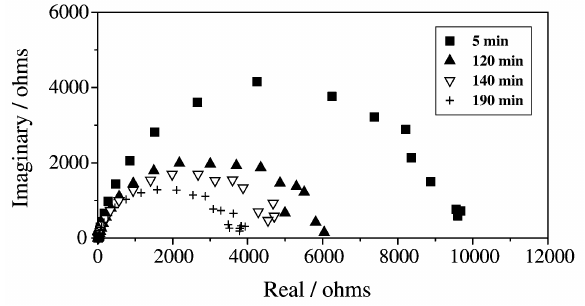
Figure 1. AFM topography images of the coatings before the electro- chemical experiments: (a) TiN film; (b) CrN film ; (c) TiC- x N y film.